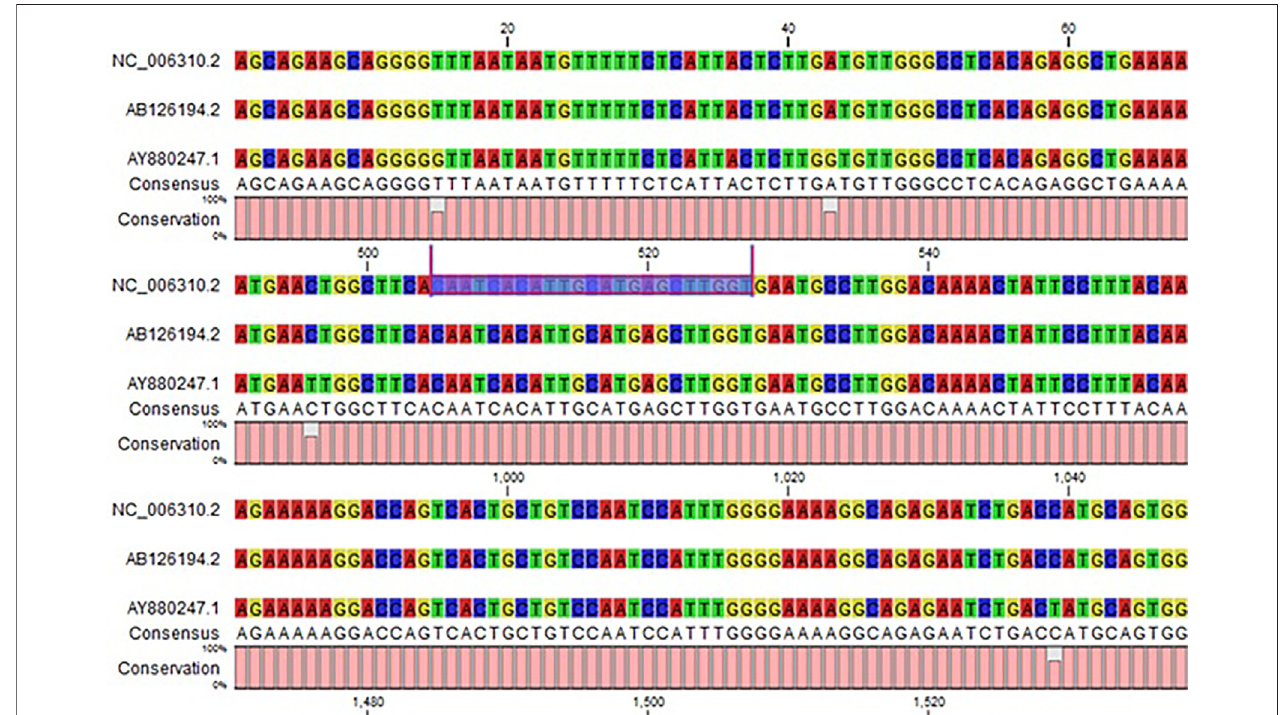
FIGURE9| Target-site conservationpattern indifferentin fl uenzastrains. Thetargetsitesarehighlightedinblue, andbars showthelevelofconservationatspeci fi c sites. Involvement of predicted proteins in in fl uenza c virus.